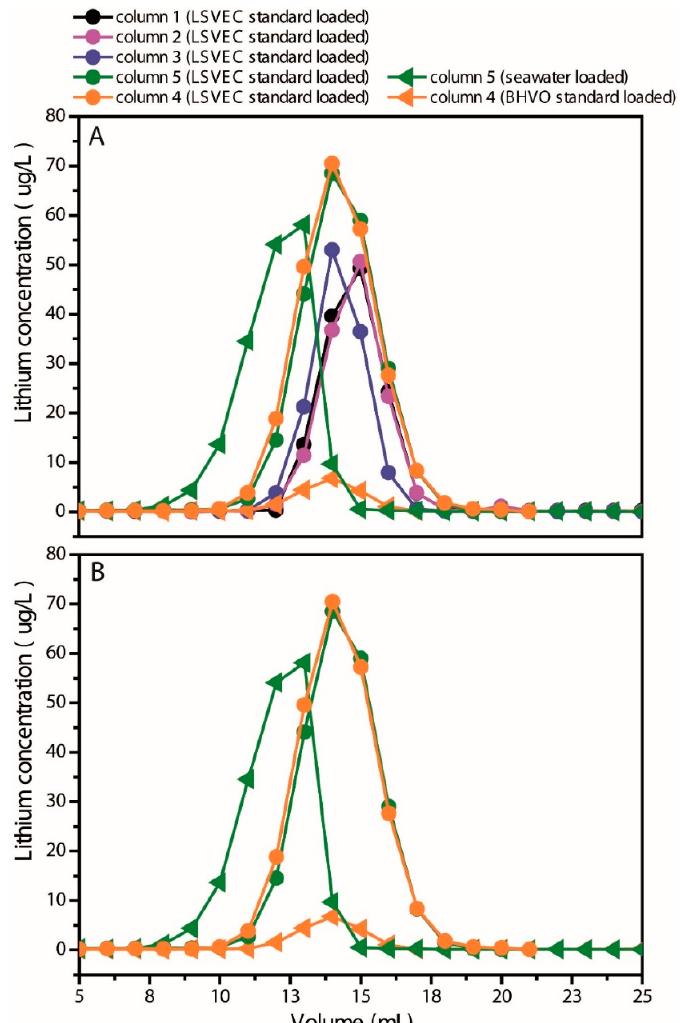
Figure 4. Calibration curve for 7 Li mass. The standard solutions were prepared by dilution from single element stock solution at 1000 mg/L, plus blank solution.